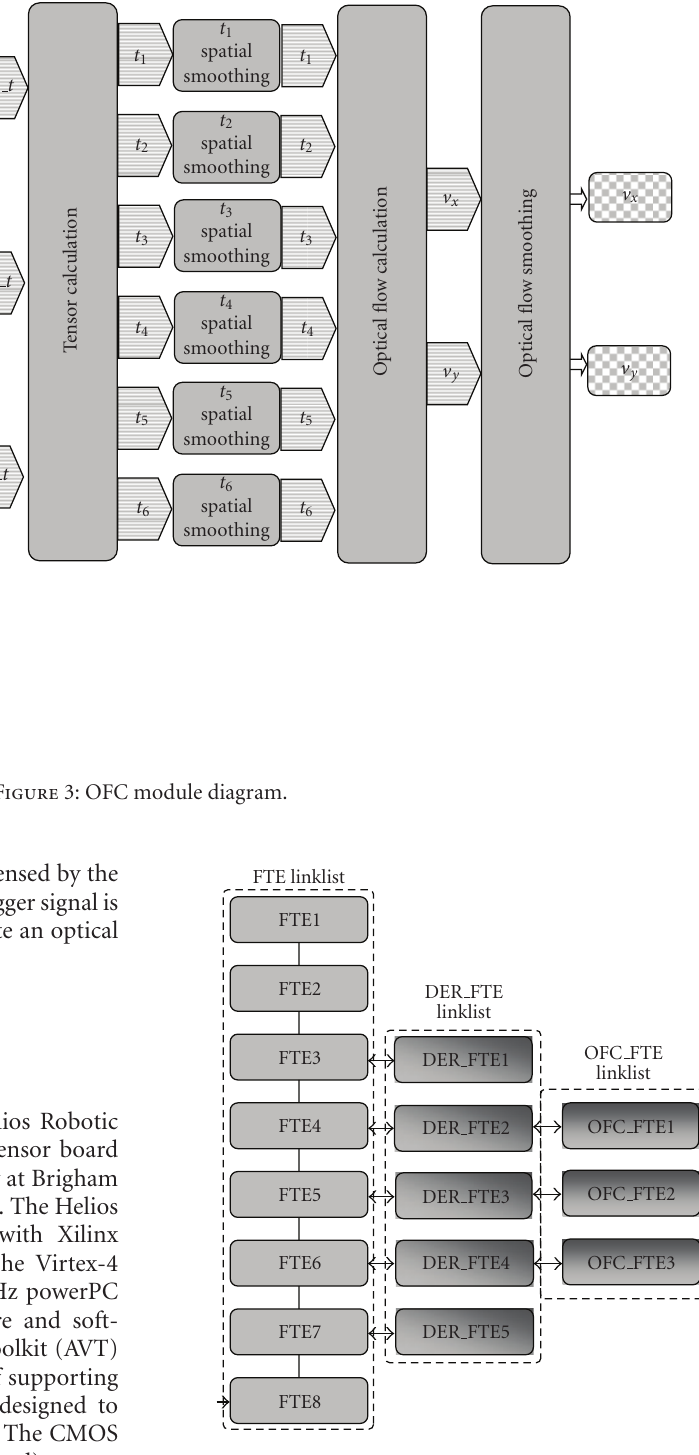
Figure 4: Software